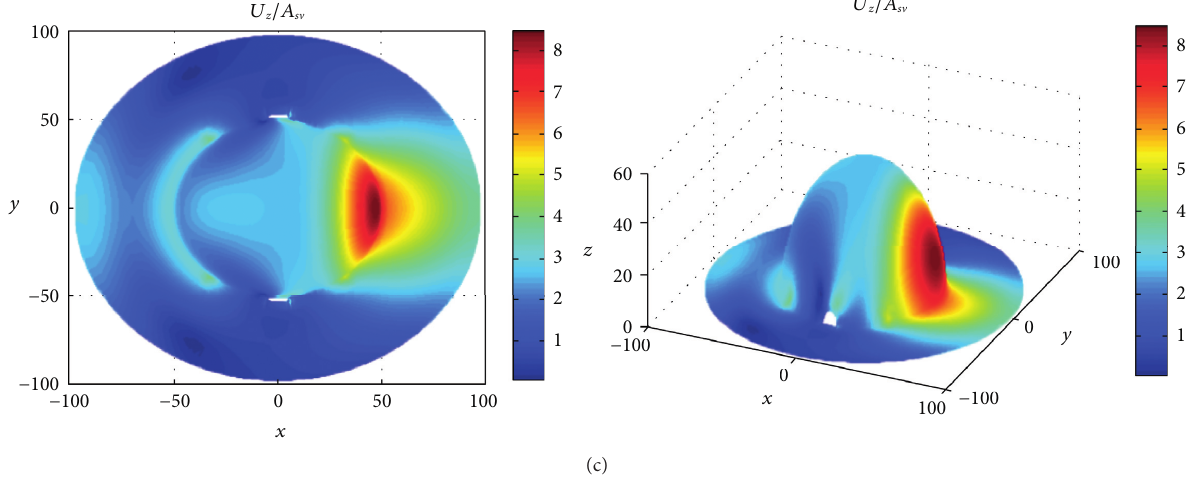
Figure 16: Surface displacement amplitude of the 3D tunnel mountain under the incident SV wave ( η � 1 . 0 , α � 30 ° ): (a) surface dis- placement amplitude in x direction; (b) surface displacement amplitude in y direction; (c) surface displacement amplitude in z